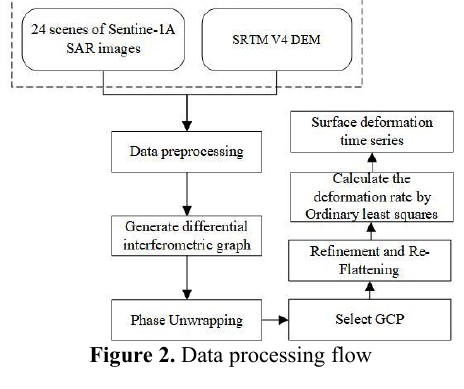
Figure 2. Data processing flow